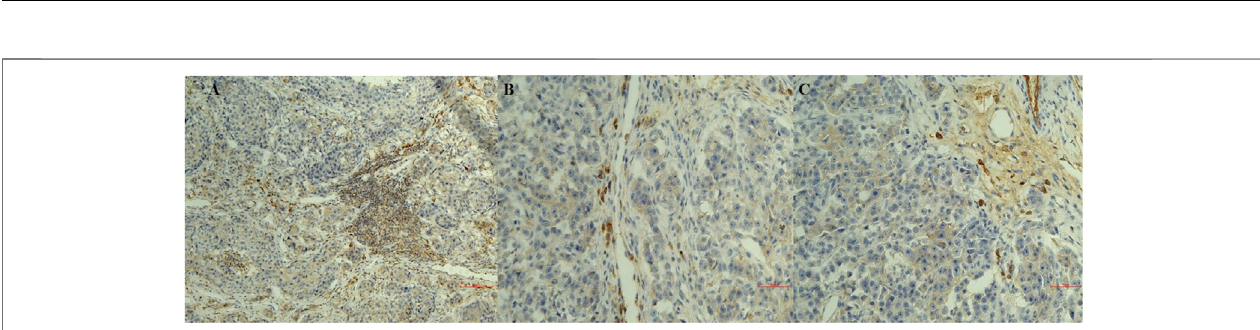
FIGURE 1 | Sections of immunostaining with a monoclonal antiCD20 + mab of canine sections from animals affected by breast cancer. (A) CD20 + Lymphocyte in fi ltratingtumorsample(20X)inaG1sample; (B) CD20+Lymphocytein fi ltratingtumorsample(40X)inaG1sample; (C) CD68+macrophagesin fi ltratingintothelymph node (20X) in a G3 sample; (D) CD68 + macrophages in fi ltrating into the lymph node in a G3 sample.